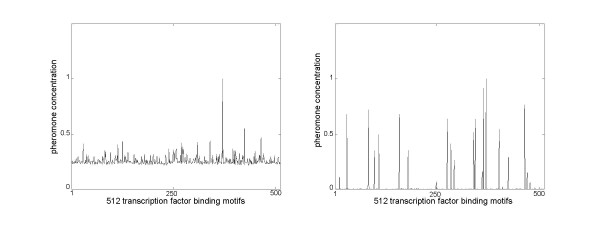
Examples of pheromone spectra. The pheromone spectra display the pheromone concentration for each DNA sequence as a potential transcription-factor binding motif. (A) Pheromone spectrum with ε = 0 and δ = 0. A single dominating peak indicates a highly selective computational condition. (B) Pheromone spectrum with ε = 500 and δ = 0.5. Multiple peaks suggest a distributed regulatory system with the given computational parameters.